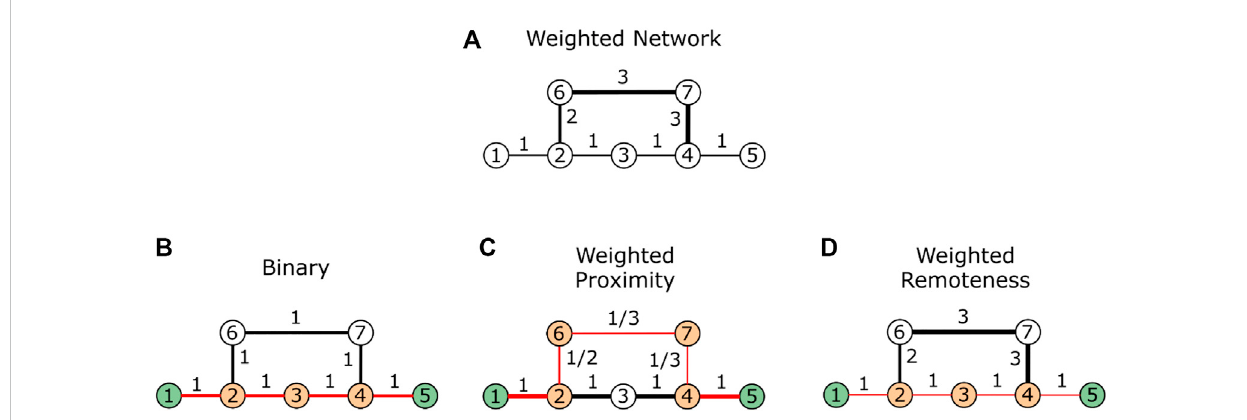
FIGURE 3 Finding the shortest path between nodes 1 and 5 in a weighted network. (A) The weighted network. (B) The binary shortest path. (C) Weighted “ proximity ” shortest path. (D) Weighted “ remoteness ” shortest path. The links forming the shortest path are in red, and nodes belonging to the shortest path are in orange. Wecan seehow, by changing the methodology used to compute the distances among nodes in thesocial network, the shortest path between the nodes may change as